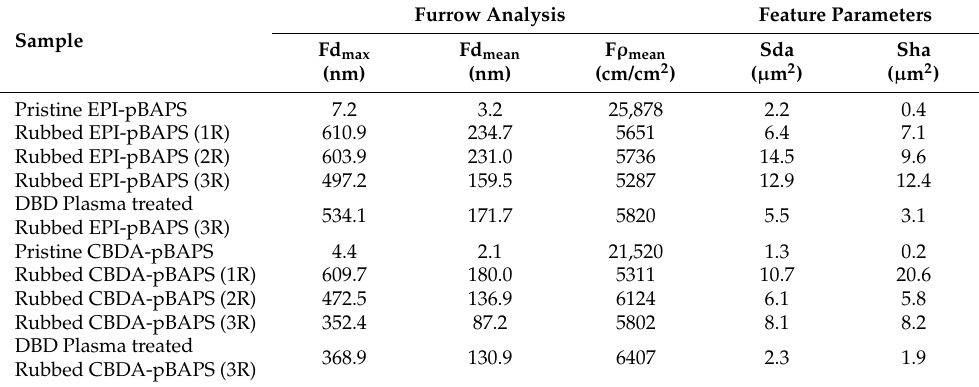
Table 3. Furrow and feature parameters calculated from the AFM measurements of the pristine, rubbed along different directions and plasma-treated samples. Furrow Sample